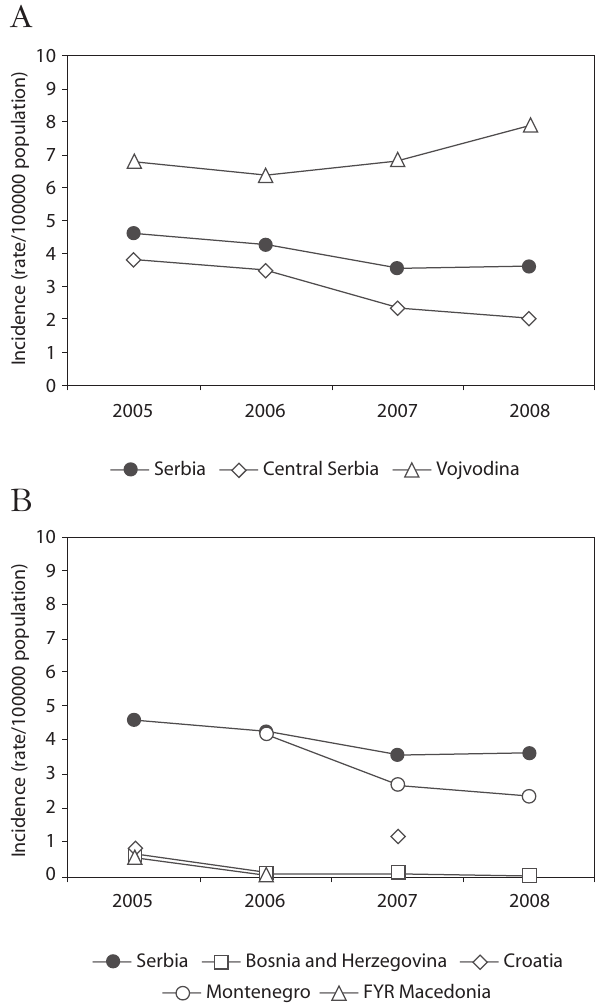
Fig. 2. – Changes in incidence of symptomatic human Giardia infections in Serbia vs (A) Vojvodina and Central Serbia and (B) other Western Balkan Countries (Bosnia and Herzegovina, Croatia, Montenegro and FYR Macedonia) between 2005 and